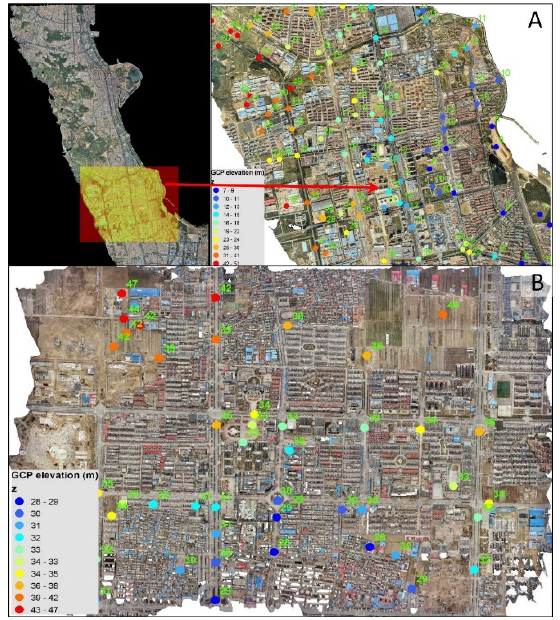
Figure 8. The distribution of GCPs in two OAP3D datasets used for generating 2.5D maps and assessing quality: ( A ) Dataset 1 in a rugged terrain; ( B ) Dataset 2 in a gentle terrain. quality: ( A ) Dataset 1 in a rugged terrain; ( B ) Dataset 2 in a gentle